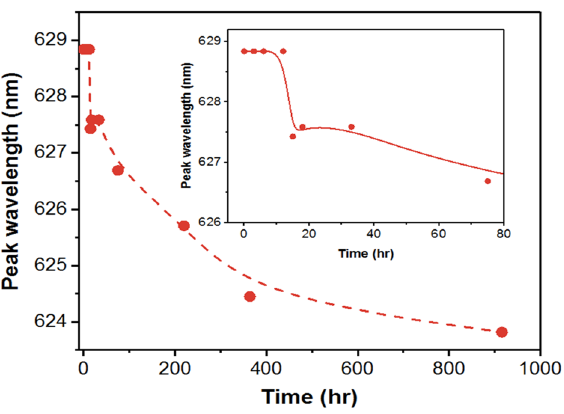
Figure 11. Average of variation of QDs peak wavelength vs. test time tested under ambient